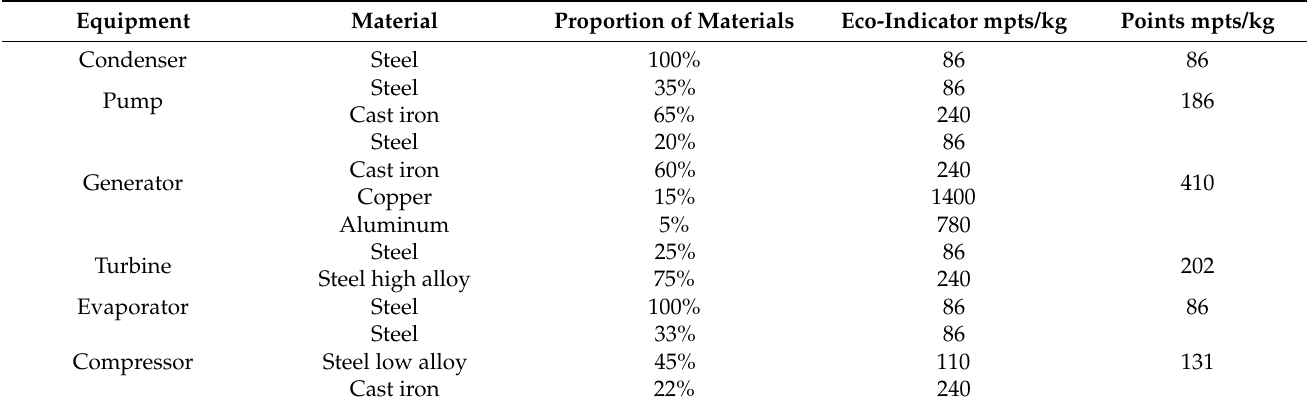
Table 3. Eco-indicator for materials for system equipments.